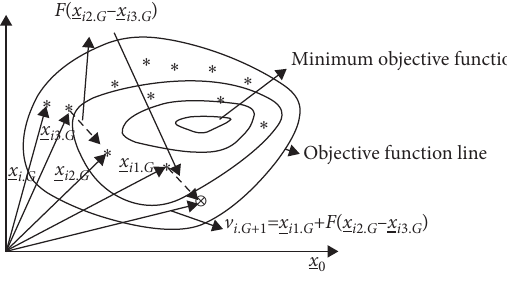
Figure 1: Schematic diagram of variation